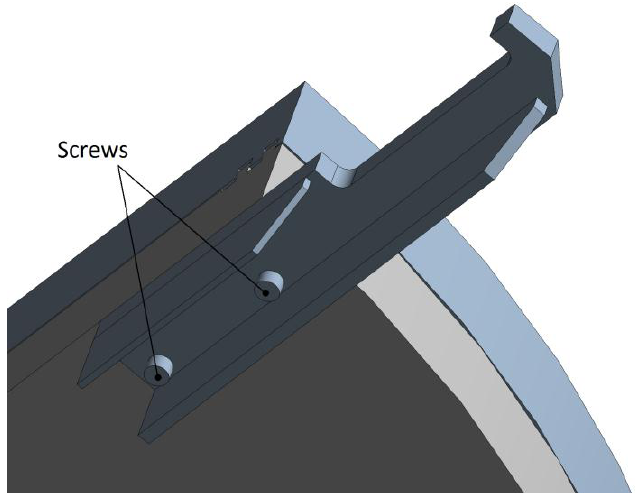
Figure 10. FE displacements of the Transfer Machine with nine divisions with E ring = 39 GPa.